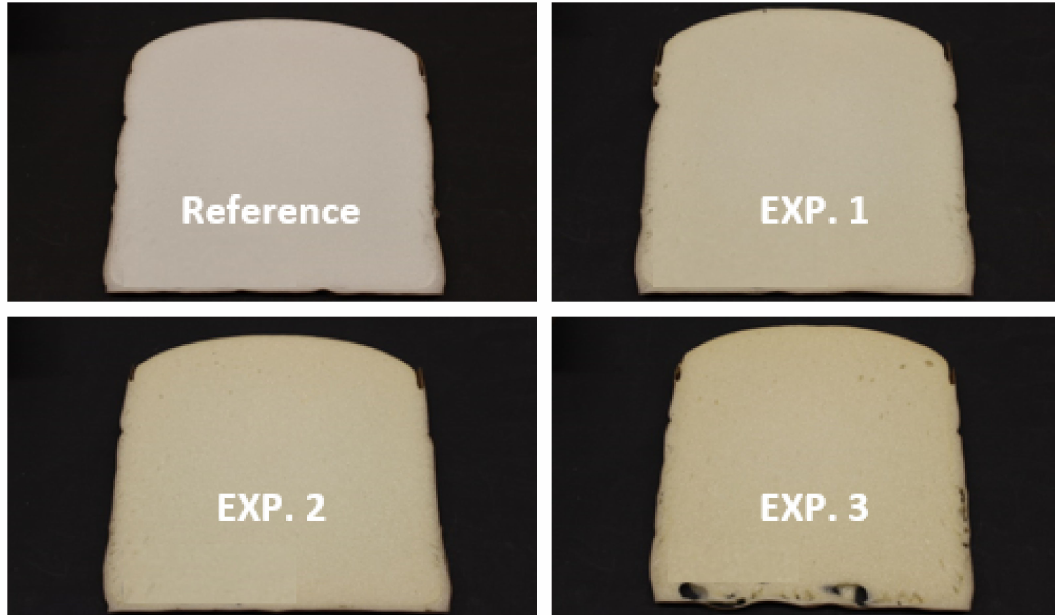
Figure 3. Optical photographs of the cross-section surface of the reference foam and of PU foams obtained at different reference polyol/recycled polyol ratios, 90:10 in EXP. 1, 80:20 in EXP. 2 and 70:30 in EXP 3 (the formulations are presented in Tables 1 and